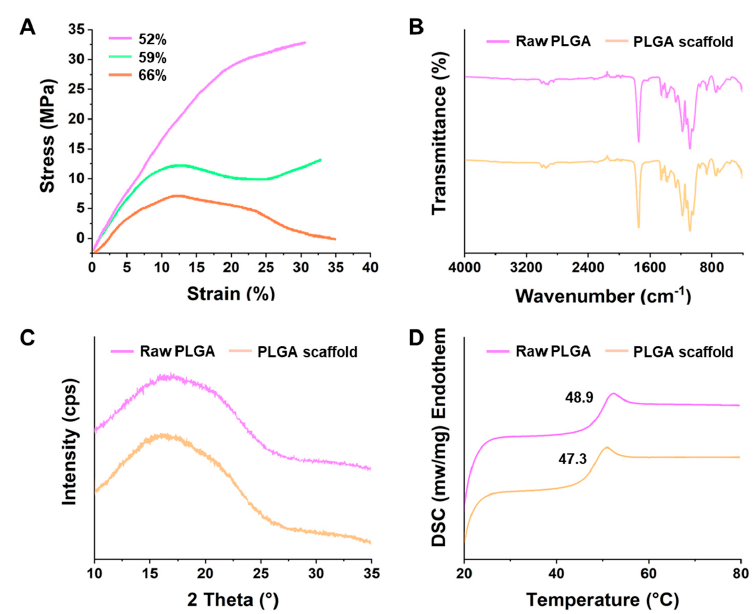
Figure 3. ( A ) Strain-stress curves at different porosity levels of the scaffolds. ( B ) FTIR spectra, ( C ) XRD curves, and ( D ) the DSC curves of the raw PLGA and the PLGA scaffold.